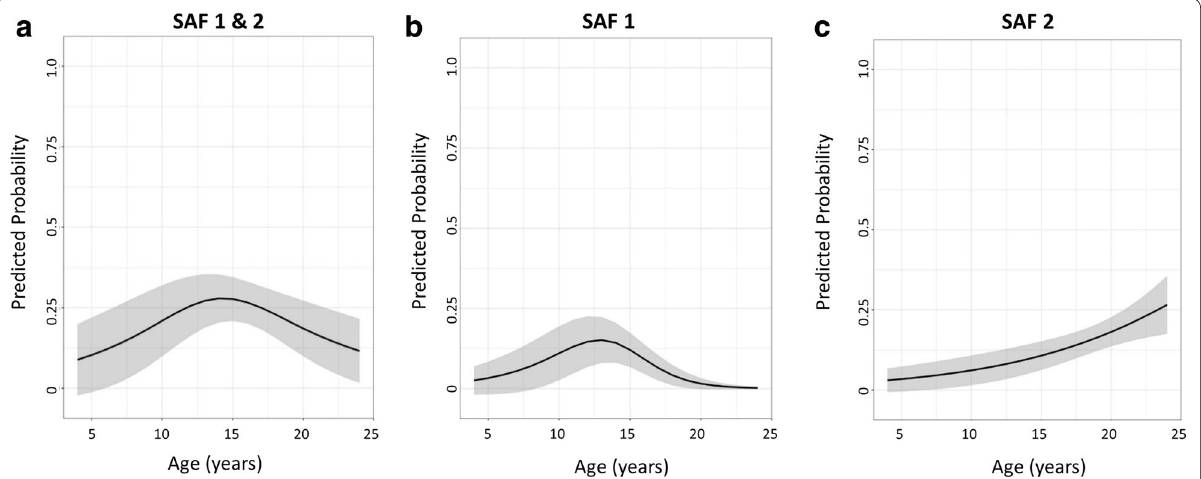
Fig. 2 Age-dependent predicted probability with corresponding 95% confidence bands of SAF type 1/type 2 ( a ), SAF type 1 ( b ) and SAF type 2 ( c